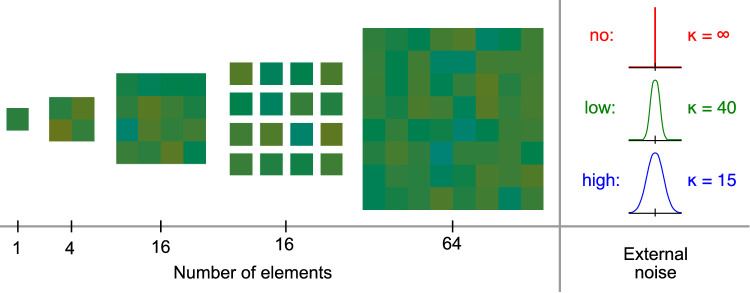
Experimental conditions for Experiment 1. The experiment included five different types of stimuli as seen on the left side of the figure and three levels of added noise for the element hues on the right. The one-element stimulus was only tested in the no-noise condition to avoid redundancy. Please note that the stimulus examples here and in subsequent figures are shown for illustration only and do not exactly match the stimuli in the experiment, which were color-calibrated and shown on a gray background.